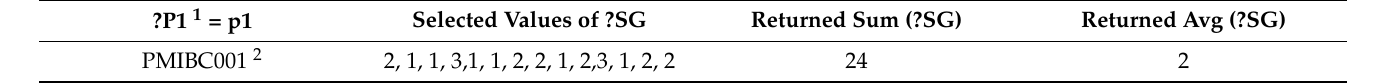
Table 5. SQWRL severity grades results related to predicted side